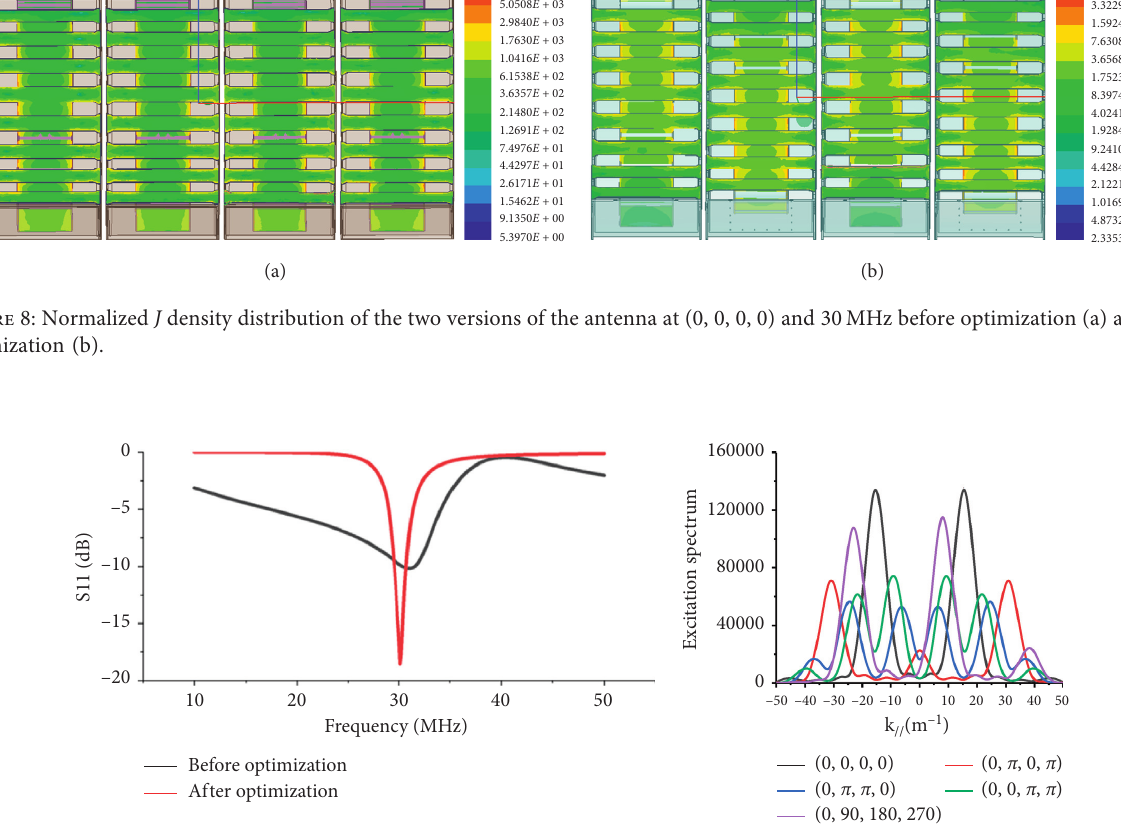
// spectrum of the optimized antenna